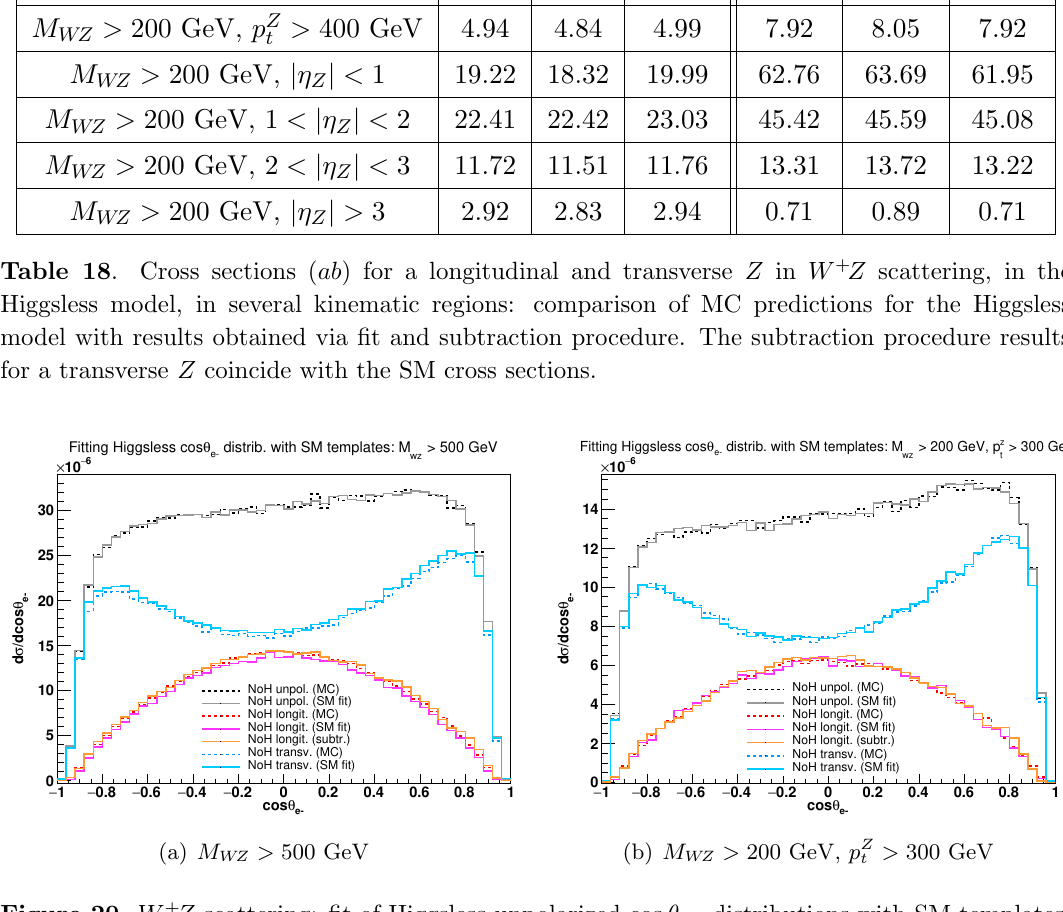
Figure 20 . W + Z scattering: (cid:12)t of Higgsless unpolarized cos (cid:18) in two di(cid:11)erent kinematic regions (large mass and large p t ). For the longitudinal component the result of the (cid:12)t (magenta) and the one of the subtraction technique (orange) are compared with the Monte Carlo expectation (dashed